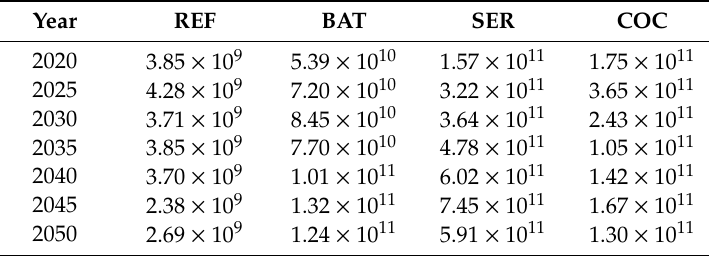
Table 8. Total emission reduction cost of air pollutants